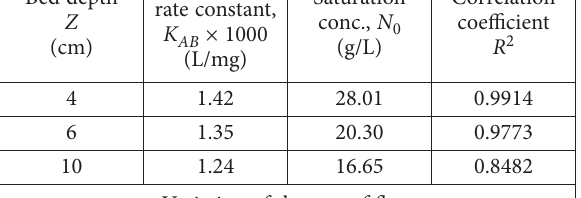
Table 2. Bohart-Admas model parameters Variation of the bed depth The flow rate is 10 ml/min, and the inlet conc. is 10 mg/L